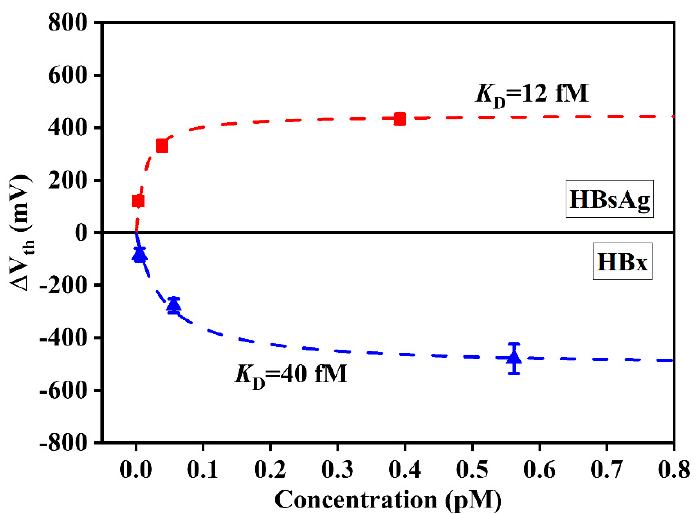
Figure 5. The threshold voltage changes and K D of HBsAg and HBx biosensing. The red line indicates that the threshold voltage increases accordingly to the increased HBsAg concentration, whereas the blue line indicates that the threshold voltage decreases accordingly to the increased HBx concentration. The extraction K D of HBsAg and HBx were obtained at 12 fM and 40 fM, respectively. The error bar was indicated the standard error of three